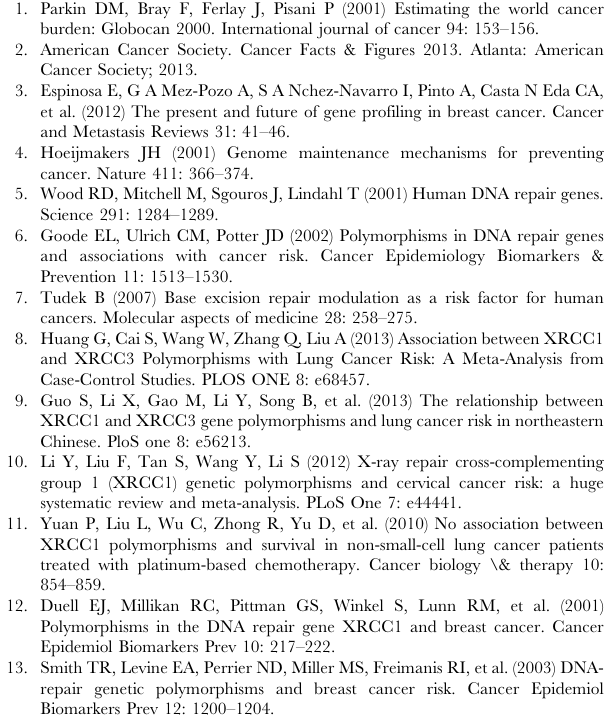
Figure S2 Forest plot of the association between the XRCC1 Arg399Gln and breast cancer risk of menopausal subgroup for the dominant model. (TIF) Figure S3 Forest plot of the association between the XRCC1 Arg399Gln and breast cancer risk of menopausal subgroup for the recessive model. (TIF) Figure S4 Forest plot of the association between the XRCC1 Arg399Gln and breast cancer risk of menopausal subgroup for the additive model. (TIF) Figure S5 Sensitivity analysis of the association be- tween the XRCC1 Arg399Gln and breast cancer risk the recessive model. (TIF) Figure S6 Funnel plot of the association between the XRCC1 Arg399Gln and breast cancer risk for the recessive model. (TIF) Table S1 Quality assessment of case–control studies included in this meta-analysis. Table S2 Data of premenopausal or postmenopausal